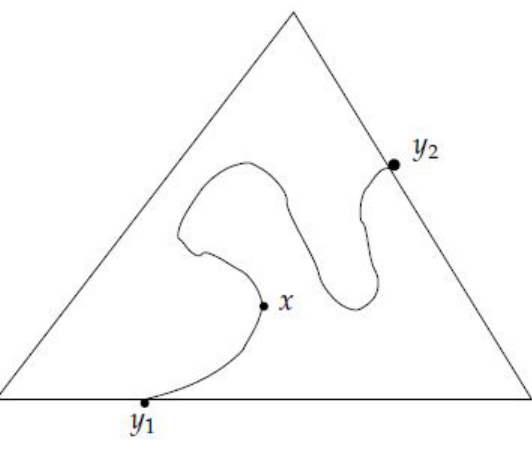
Figure 7. The curvature inside a